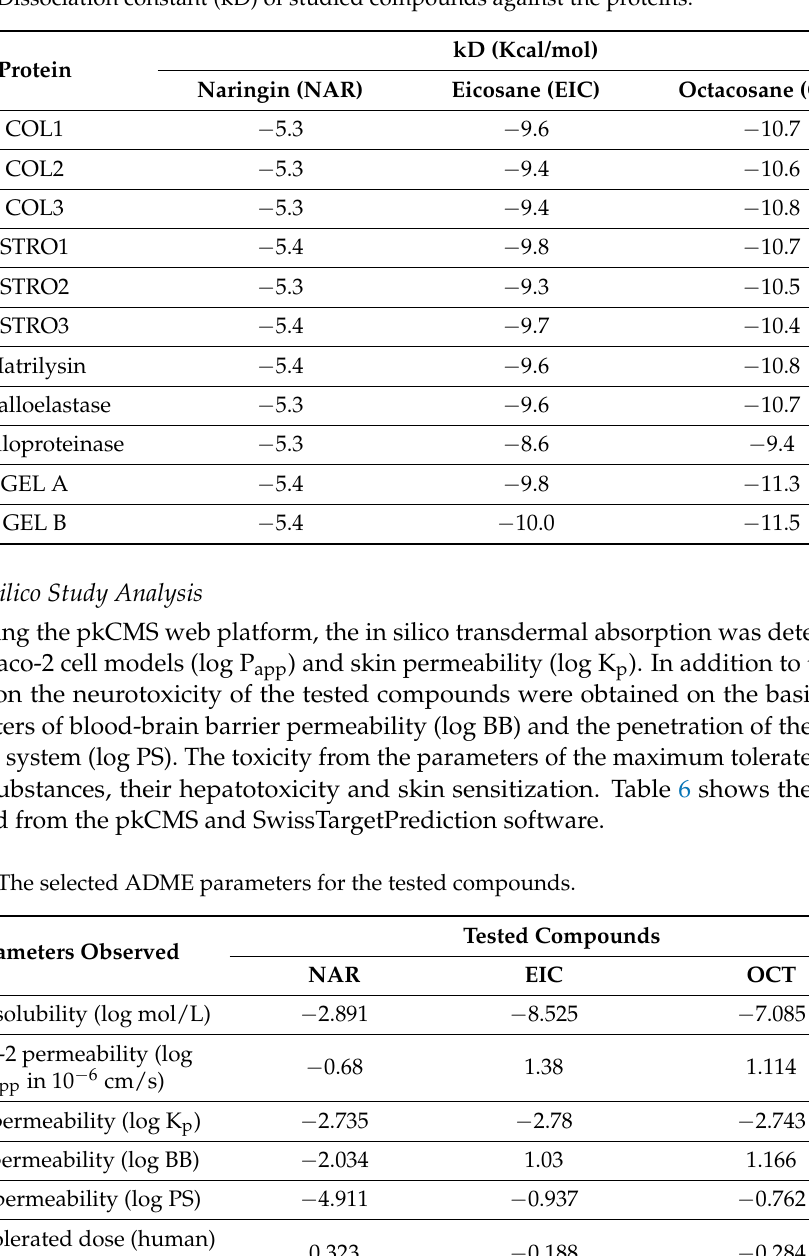
Table 5. Dissociation constant (kD) of studied compounds against the proteins.